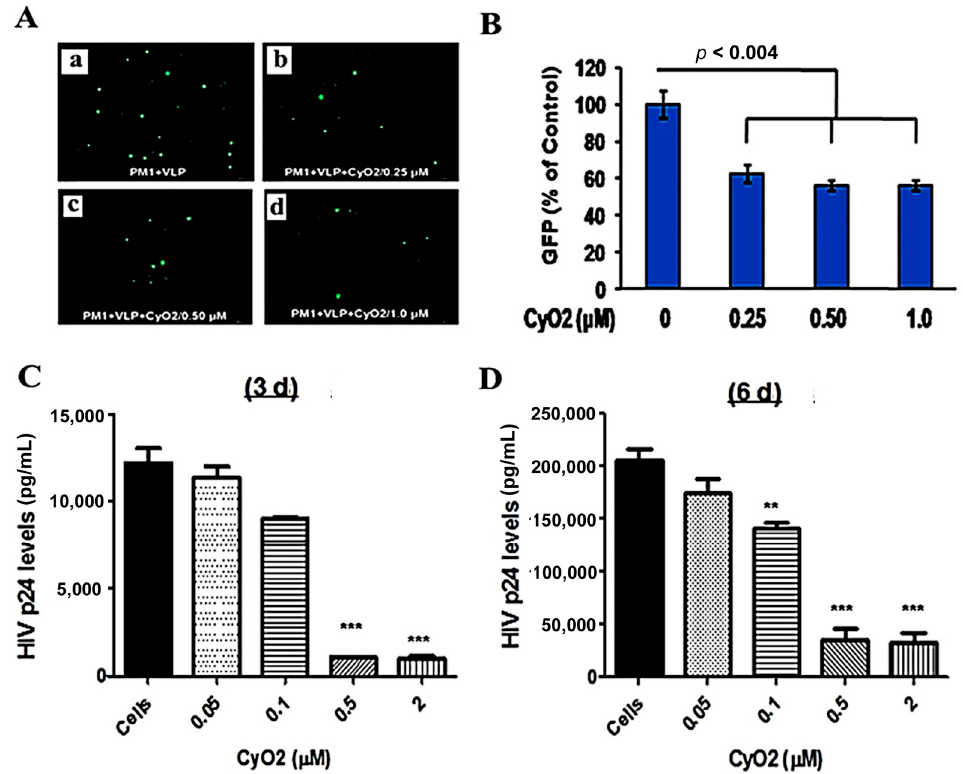
Figure 6. Effect of CyO2 on infectivity of viral particles. In ( A , B ), PM1 cells were incubated with untreated (control) or CyO2 (0.25–1.0 µ M) treated virus-like particles (VLP) and changes in GFP expressing cells were measured after 48 h. A representative image of GFP-positive cells is shown in ( A ) and percent change in GFP-positive cells is shown in ( B ). Pre-exposure to CyO2 decreases the infectivity of VLPs. In ( C , D ), the HTLVIIIB cell-free virus (CFV) were exposed to CyO2 (0.05–2.0 µ M) for 2 h prior to incubation of PM1 cells. HIV-1 p24/Gag levels in culture supernatants were measured after 3-day (C) and 6-day (D). Exposure of CFV to CyO2 significantly ( p < 0.001) decreased their infectivity in PM1 cells. (**, p < 0.01; ***, p < 0.001)